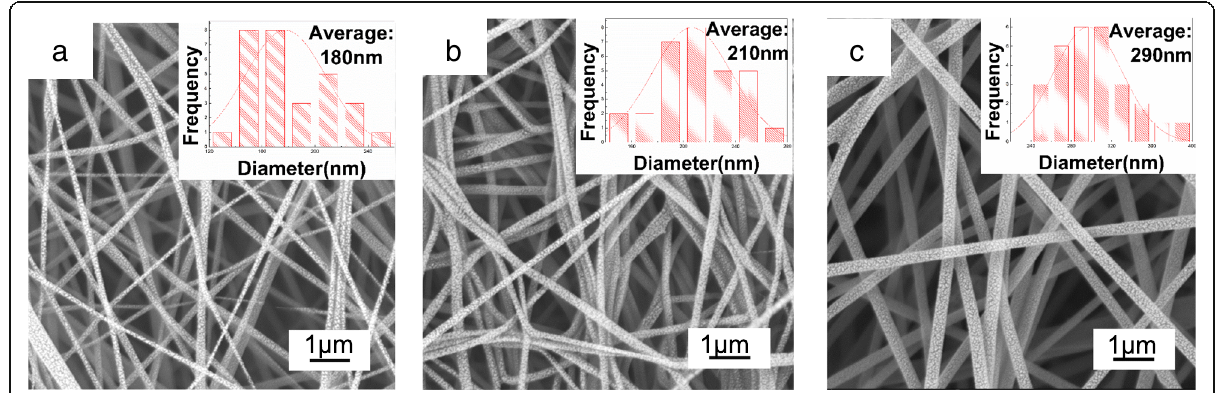
Fig. 3 SEM images and fiber diameter distribution of the electrospinning obtained from solutions of a PEO: CMCS = 1:24, b PEO: CMCS = 1:18, and c PEO: CMCS = 1:12